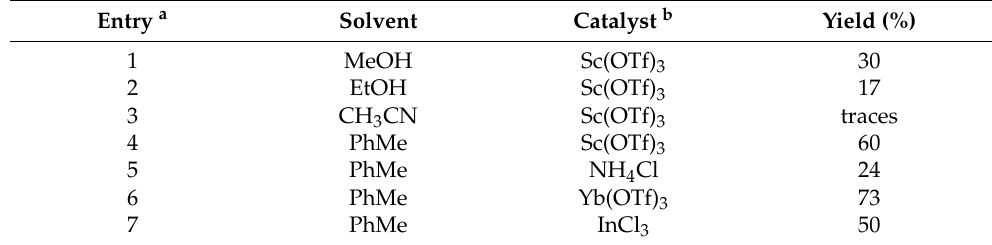
Table 1. Effect of catalysts and solvents in the synthesis of pyrrolo[3,4- b ]pyridin-5-ones. Entry